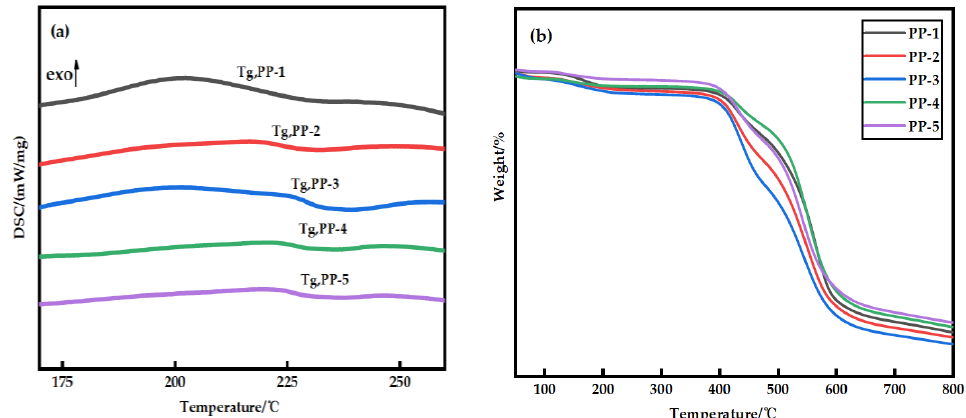
Figure 2. ( a ) Glass transition temperature of PES/PEI membranes with different ratios; ( b ) Thermo- gravimetric curves of PES/PEI membranes with different ratios.